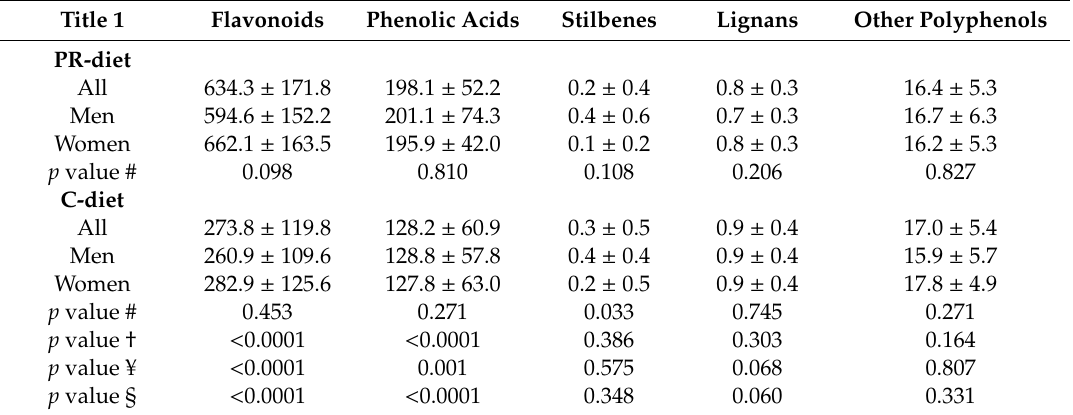
Table 4. Intake of total polyphenols and classes (according to PE / USDA databases) during the PR-diet and the